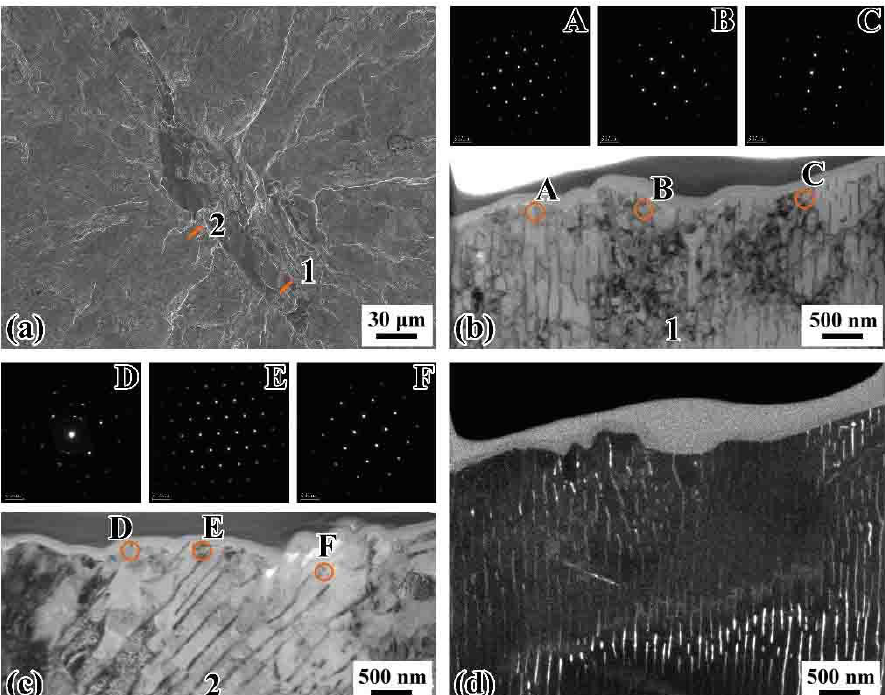
Figure 14. SEM and TEM images of extracted longitudinal-section samples cut along the loading direction for a specimen that failed at the cycles of 1.84 × 10 7 cycles under ultrasonic axial loading at R = 0.3: ( a ) SEM image of the longitudinal-section positions; ( b , c ) bright-field images of TEM samples 1 and 2, respectively; the labels A – F mark the SAD locations; ( d ) dark-field image of TEM sample 1.